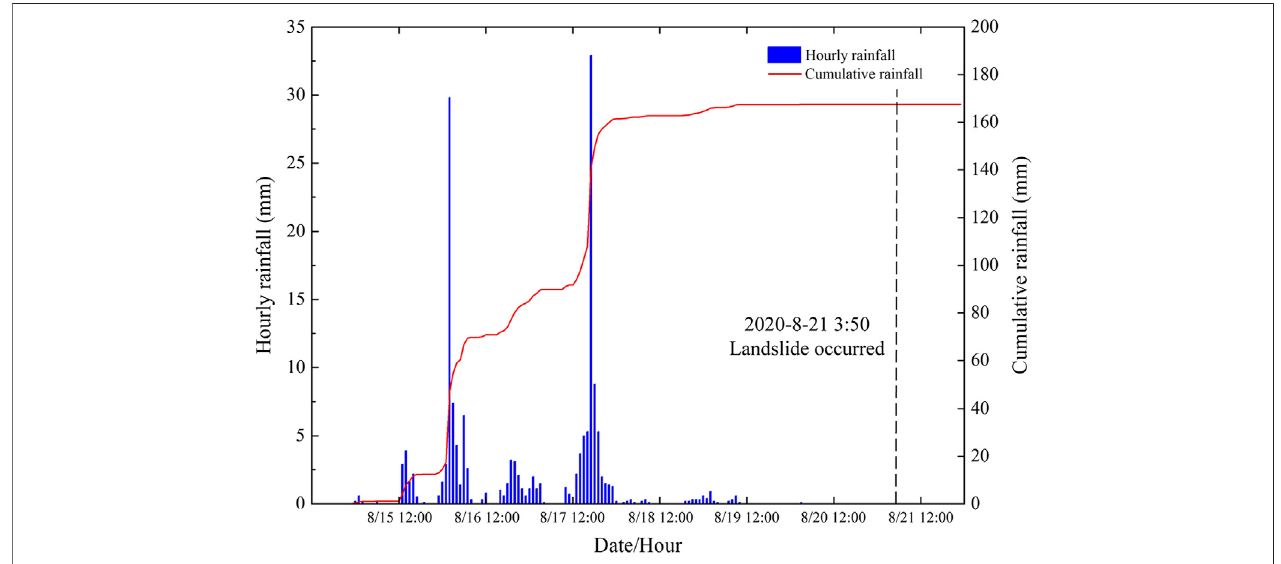
FIGURE 2 | The rainfall in 1 h intervals and cumulative rainfall before the slide. The data is provided by Anle Town rainfall station which is 2.4 km away from the landslide.